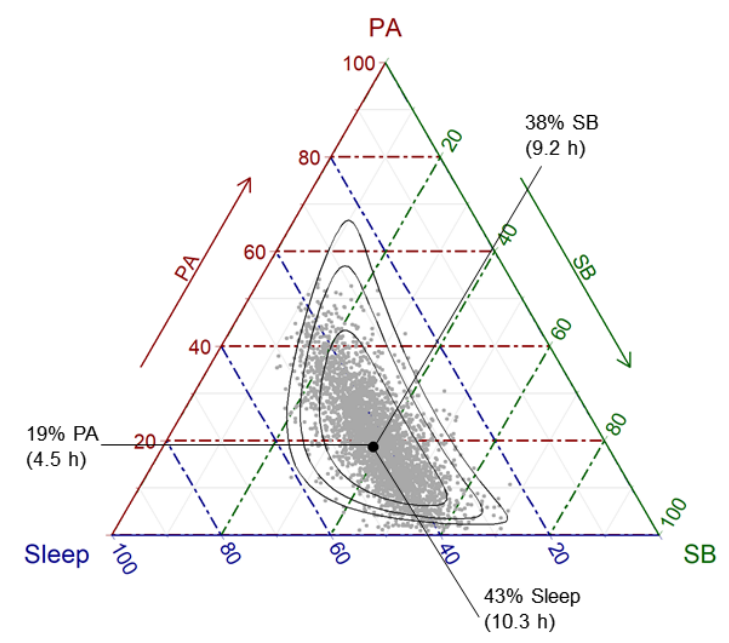
Figure 1. The ternary diagram: The Simplex sample space for a three-part composition is a triangle. Time-use data are from the Longitudinal Study of Australian Children, birth cohort, Wave 6. Black dot represents the compositional center of the time-use dataset, surrounded by 75%, 95% and 99% predictive regions from fitting a logratio normal distribution, which reflects the relative scale of compositional data [31] (see Section 3.1 for further details). PA = physical activity; SB = sedentary behavior.